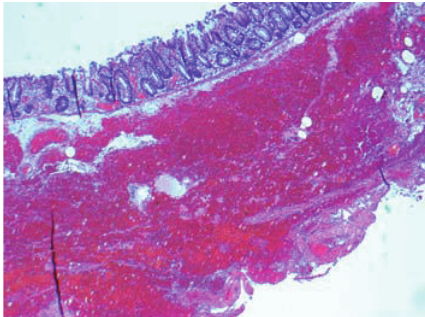
Figure 3: Intestinal biopsy showing clear signs of myopathy and a degenerated muscular